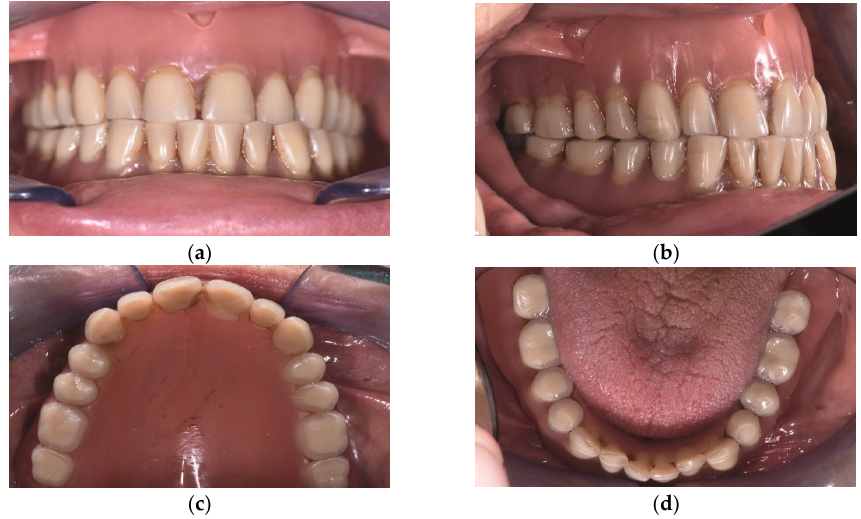
Figure 1. Intraoral view of old complete removable prostheses: ( a ) frontal view; ( b ) right lateral view; ( c ) occlusal view of upper jaw; ( d ) occlusal view of lower jaw. After the anamnestic data collection, a physical examination (intra-oral and extra-oral) was performed and it revealed a generalized muscle and joint pain upon palpation. Keeping the old complete removable prostheses in the oral cavity, occlusal contacts were analyzed, intra- and extra-oral photographs were taken, and routine radiographic examinations were